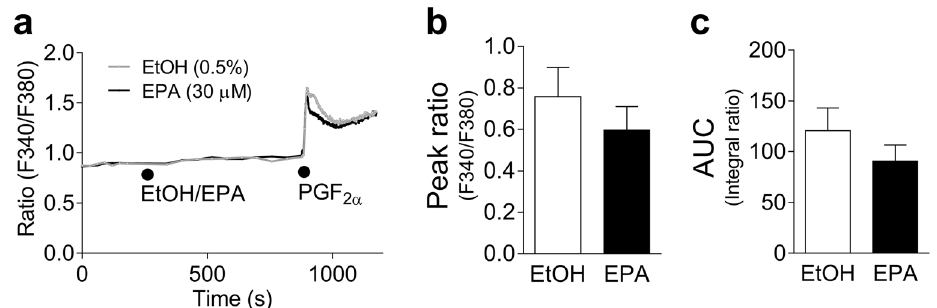
Figure 6. Changes in Fura-2 (an intracellular Ca 2+ indicator) fluorescence intensity ratio at 510 nm elicited by 340/380 nm excitation (F340/380) induced by 3 μM prostaglandin (PG) F 2α in the presence of 30 μM eicosapentaenoic acid (EPA) or 0.5% ethanol (EtOH) ( a ); quantified data of the F340/380 peak ( b ) and the F340/380 integral (area under the curve, AUC) within 5 min of PGF 2α application ( c ) in cells expressing the human prostanoid FP receptor. Changes in F340/380 are presented as means only, and quantified data are shown as mean ± SEM (each n = 10). ● : each drug